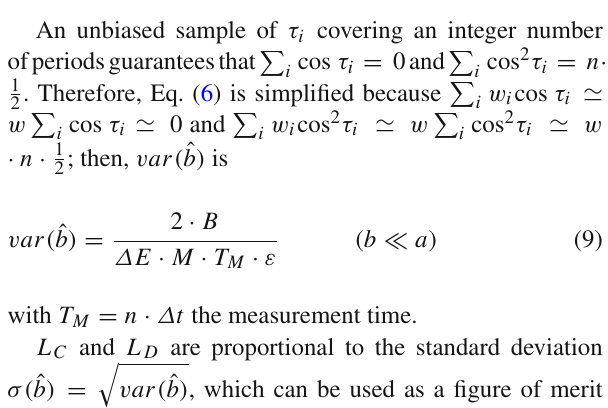
(average background, Table 1), Δ E = 4 keV ee , M = 112 . 5 kg, T M = 5 years and ε = 0 .